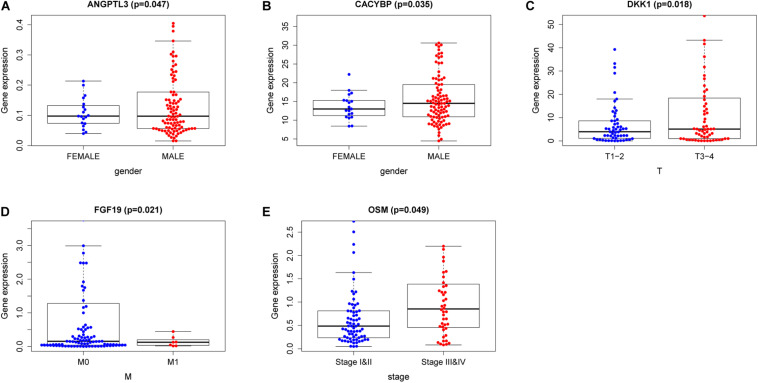
Relationships of the variables in the model with the clinical characteristics of patients. (A)
ANGPTL3 expression and gender. (B)
CACYBP expression and gender. (C)
DKK1 expression and T staging. (D)
FGF19 expression and M stage. (E)
OSM expression and pathological stage. The three horizontal lines in each picture means mean ± SD.